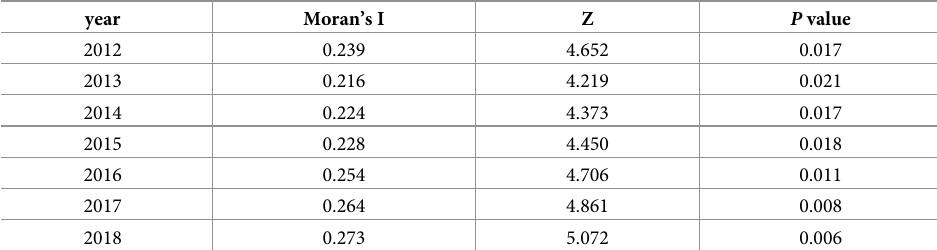
Table 1. Global spatial autocorrelation analyses for annual TB notification rate among students in Nanning, from 2012 to